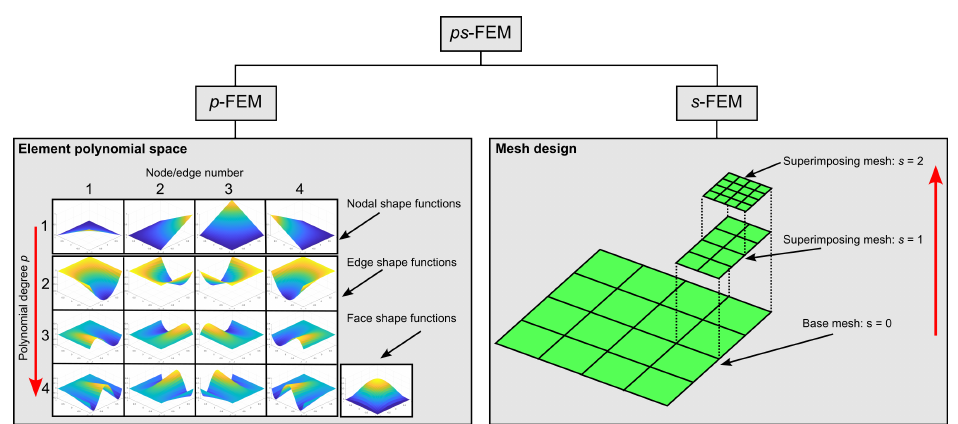
Figure 2. Building blocks of the ps − FEM